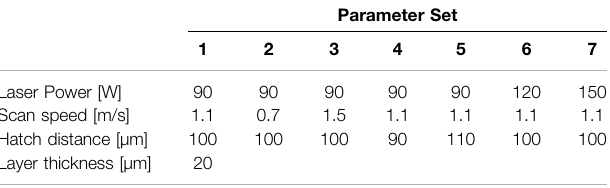
TABLE 1 | Process parameters for manufacturing density and MTPS samples.